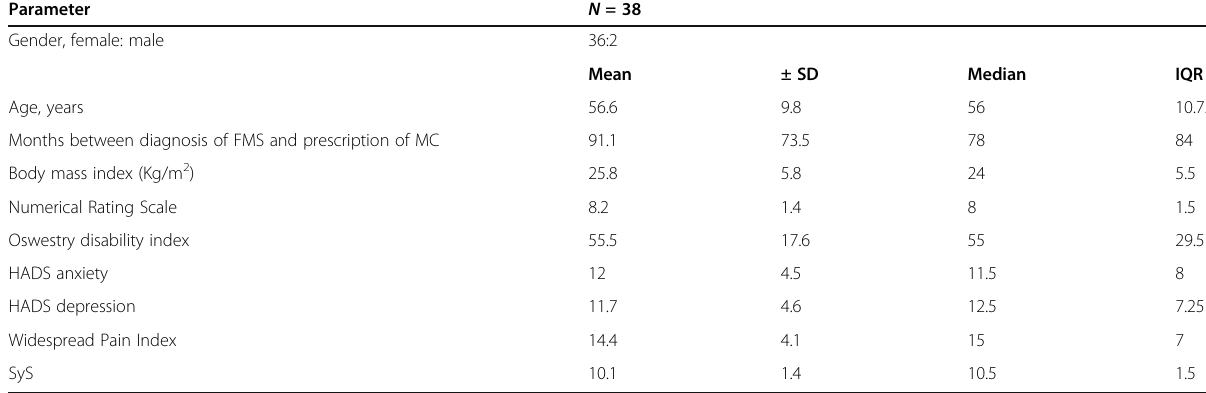
Table 2 Demographic and clinical characteristics in 38 Italian patients with fibromyalgia syndrome treated with medical cannabis